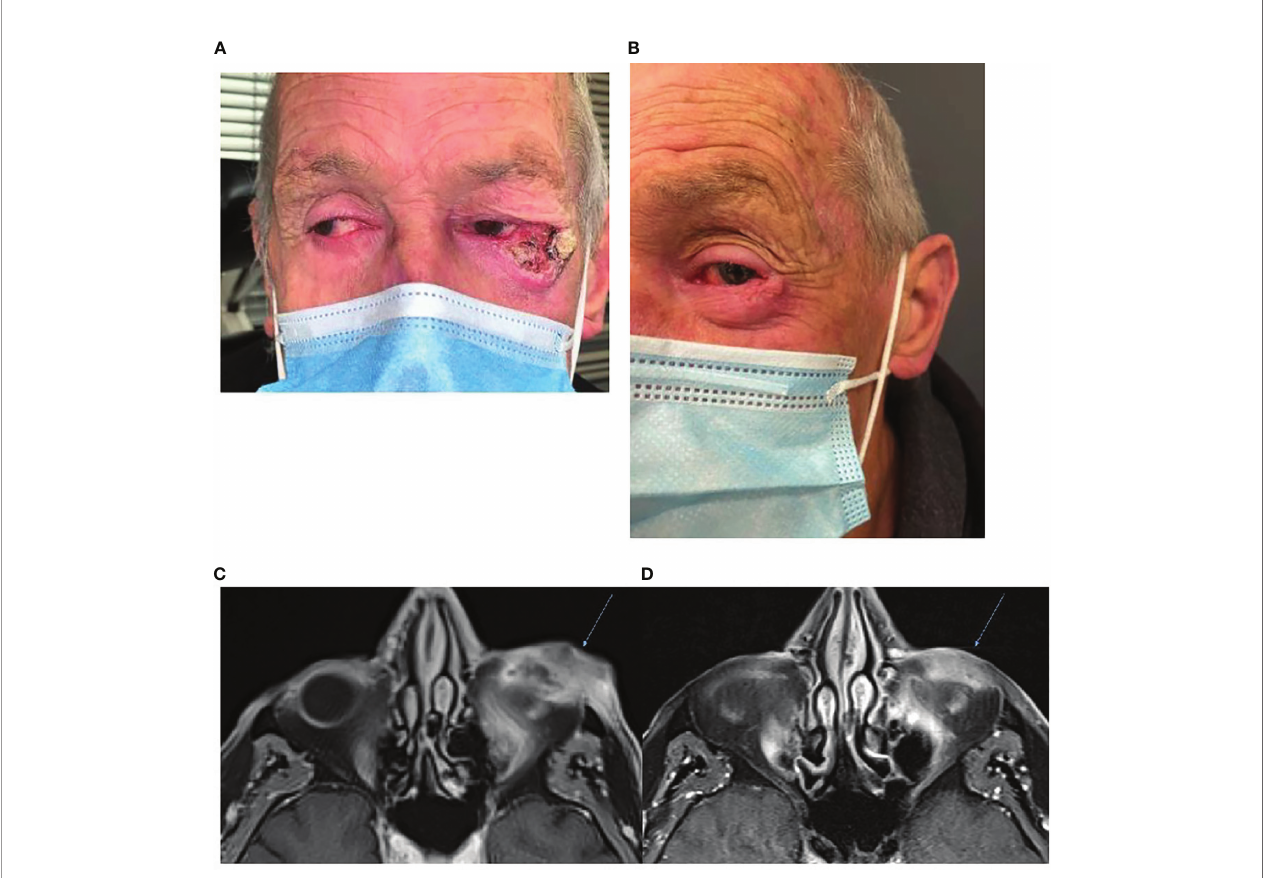
FIGURE 1 | (A) Baseline photography of leftlateral canthus CSCC prior to commencement of immunotherapy. (B) Photography of the lesion post two cycles of cemiplimab 350 mg/3-weeklydemonstrating an excellent clinical response to therapy. (C) Baseline, left, MRI post-contrastT1 Fat Sat demonstrating 38 × 18-mminferolateral canthus enhancing mass. (D) MRI post contrast T1Fat Sat, post three cycles of cemiplimab 350 mg/3-weekly demonstratingreduced size and